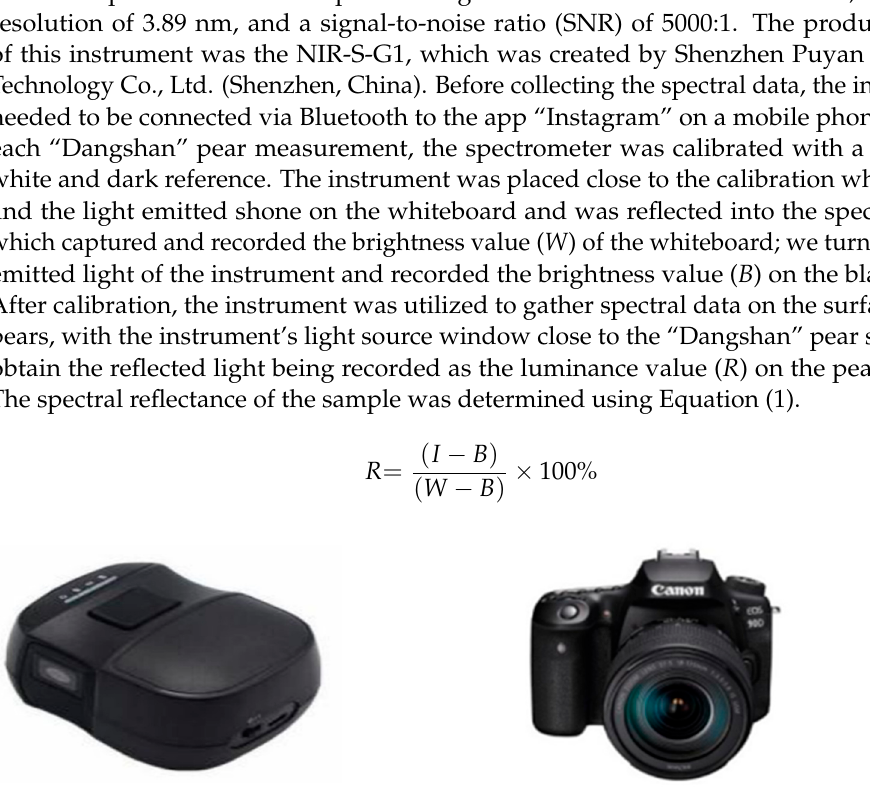
Figure 1. Diseased sample.